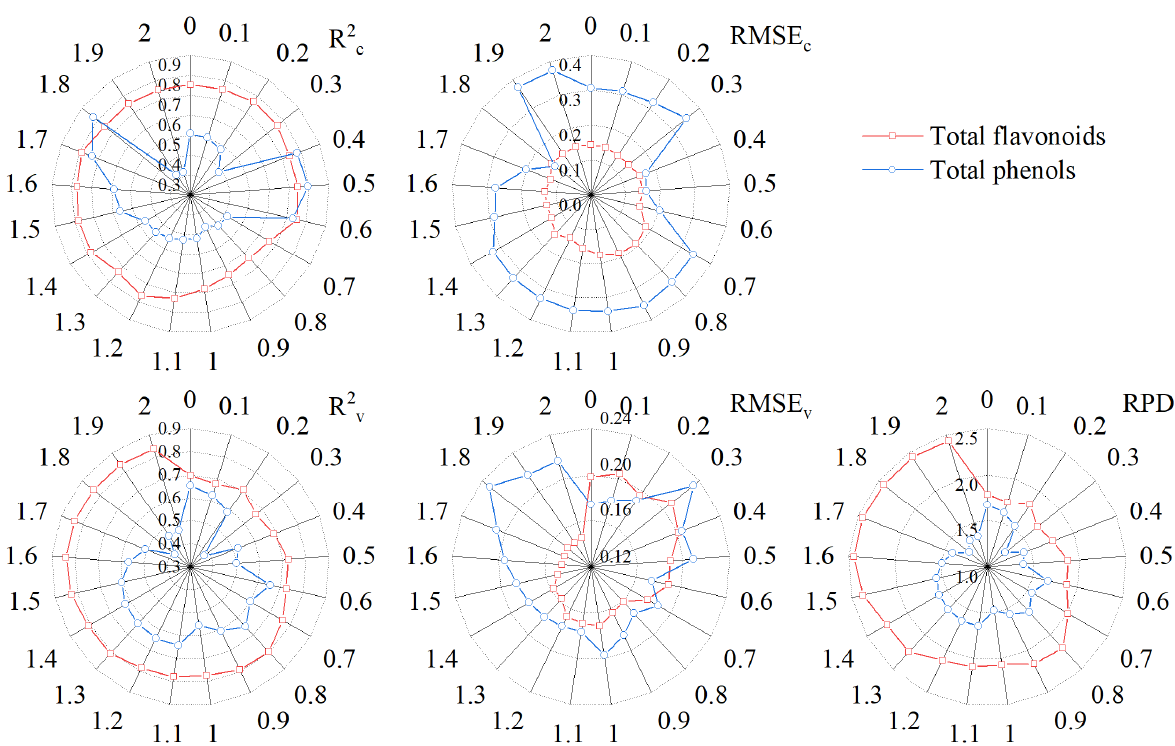
Figure 6. PLSR monitoring model of total fl avonoids and total phenols in grains based on FOD.